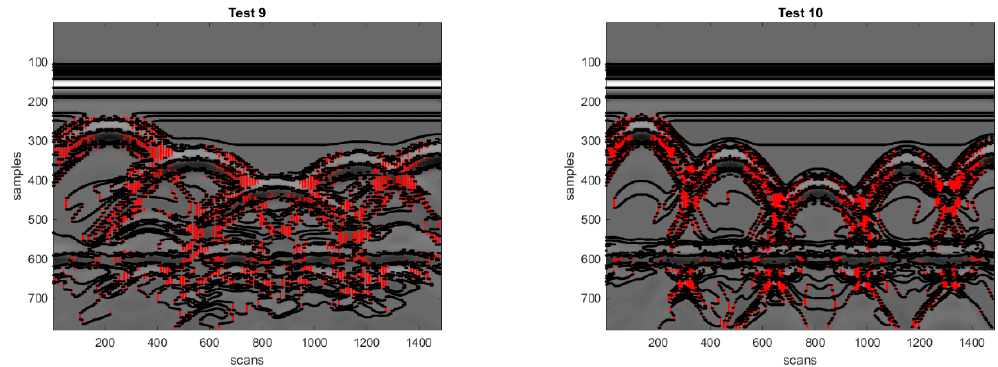
Figure 9. Edge pixel removal results obtained with synthetic test data, when using search zone (d).